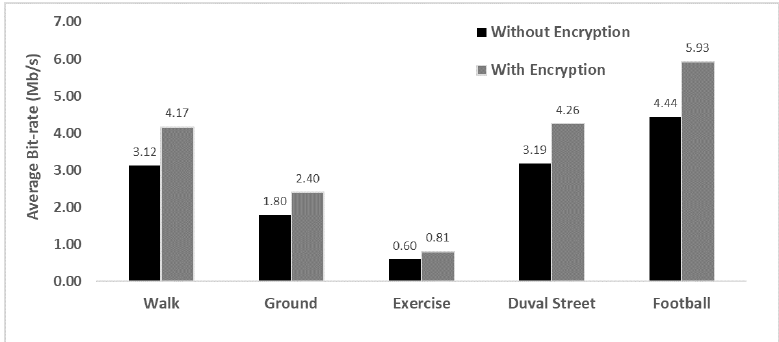
Figure 10. Bit rates with and without encryption for five evaluation